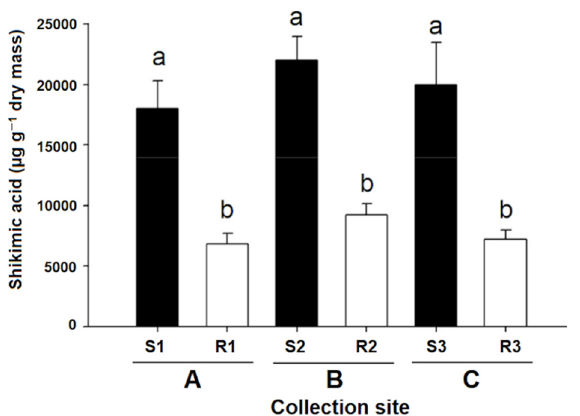
Figure 2. Shikimic acid accumulation in leaf tissues of glyphosate-susceptible (S) and -resistant (R) Conyza bonariensis biotypes at seven days after application of 720 g ae ha − 1 glyphosate. Seeds were collected in Passo Fundo-RS ( A ), Palmeira-PR ( B ), and Matão-SP ( C ), Brazil. Vertical lines represent the standard error of means ( n = 10). Different letters denote statistical differences within a collection site according to the 95% Tukey test.